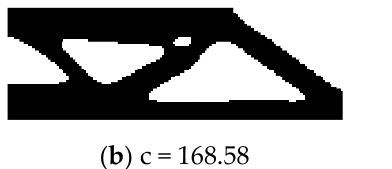
( j ) c = 62.692 Figure 8. Final results from 10 runs of cantilever beam.